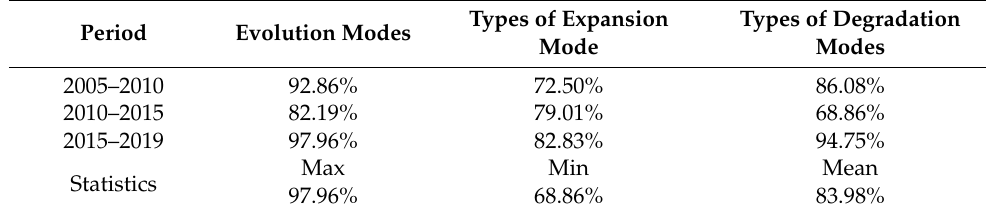
Table 4. Prediction accuracy of the random forest model.